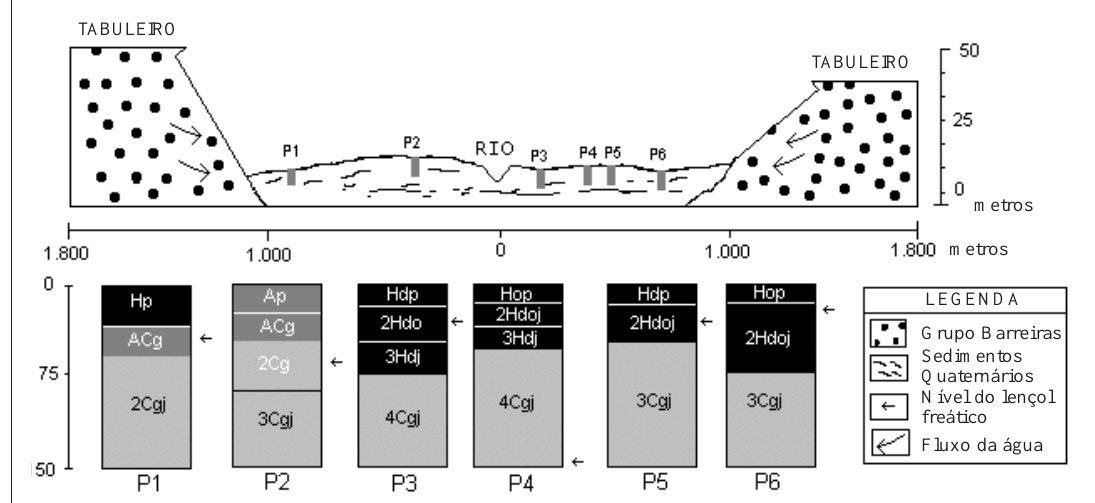
Figura 1. Localização dos perfis estudados em relação à topografia e à